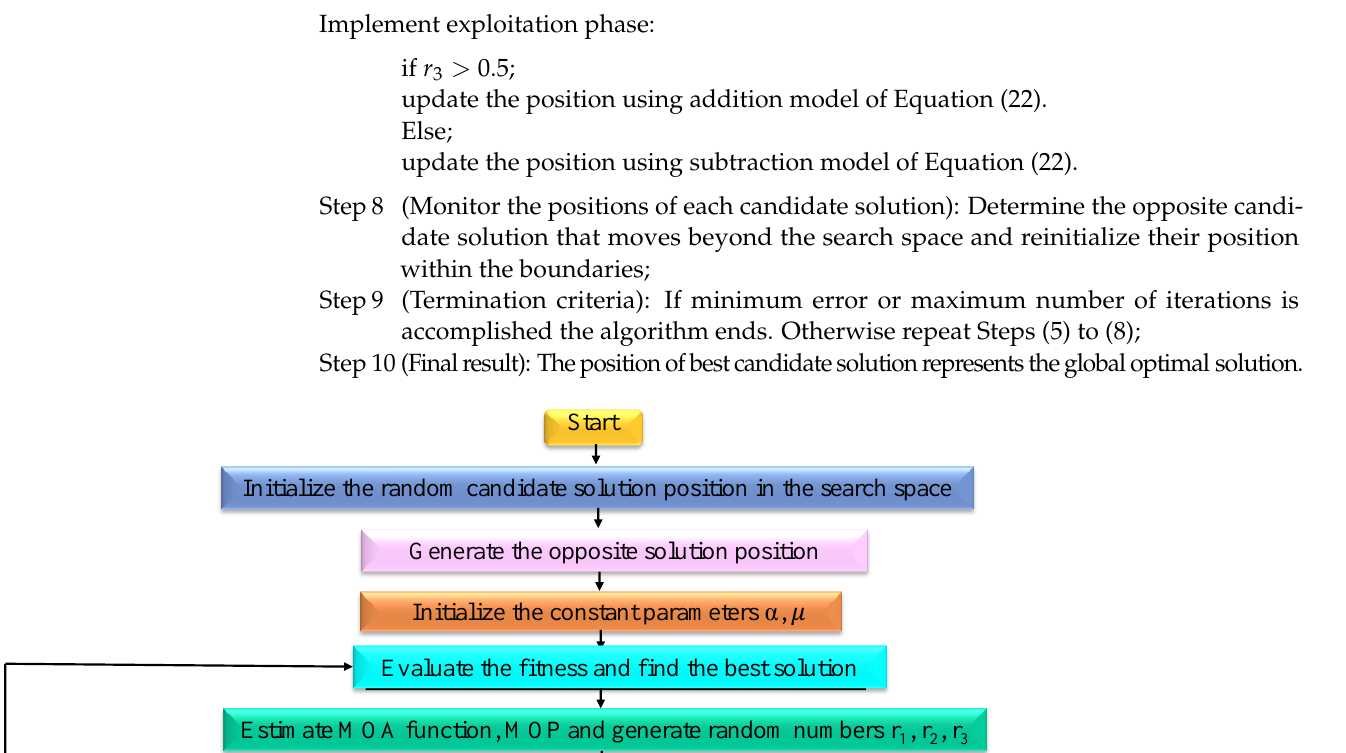
Initialize the constant parameters α,